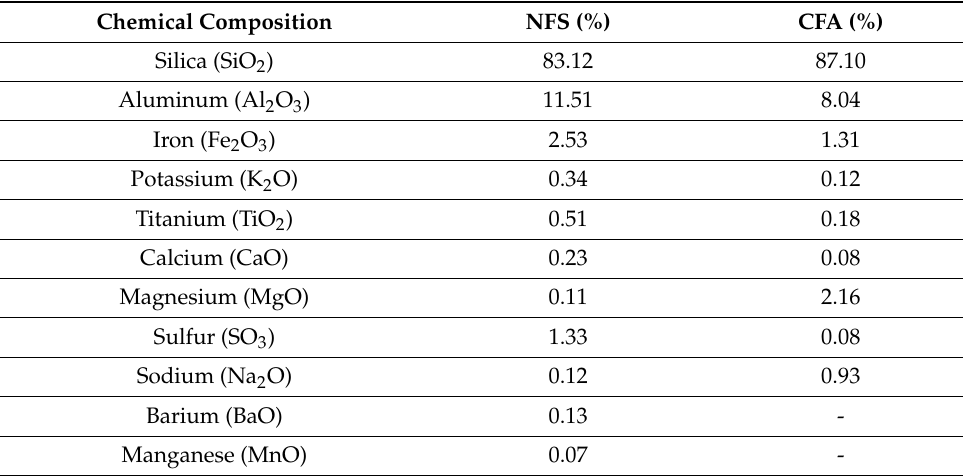
Table 1. XRF results of natural desert sand (NFS) and crushed fine aggregate (CFA). Chemical Composition NFS